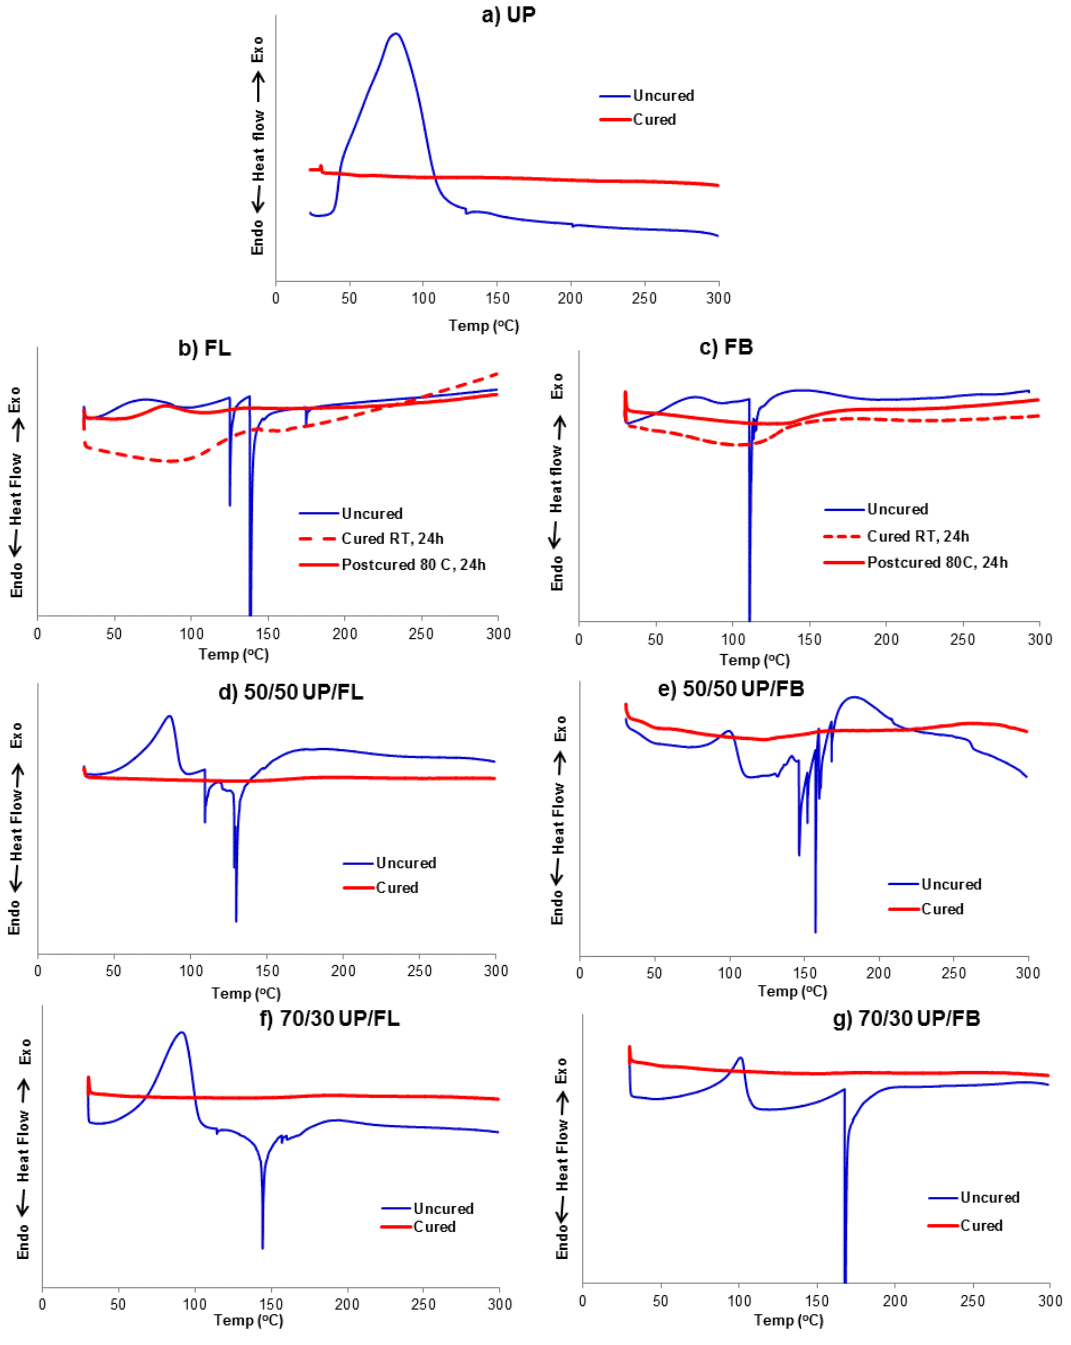
Figure 2. DSC traces for uncured and cured samples of ( a ) UP; ( b ) FL; ( c ) FB; ( d ) 50/50 UP/FL; ( e ) 70/30 UP/FL; ( f ) 50/50 UP/FL and ( g ) 70/30 UP/FB recorded at 5 °C/min under N 2